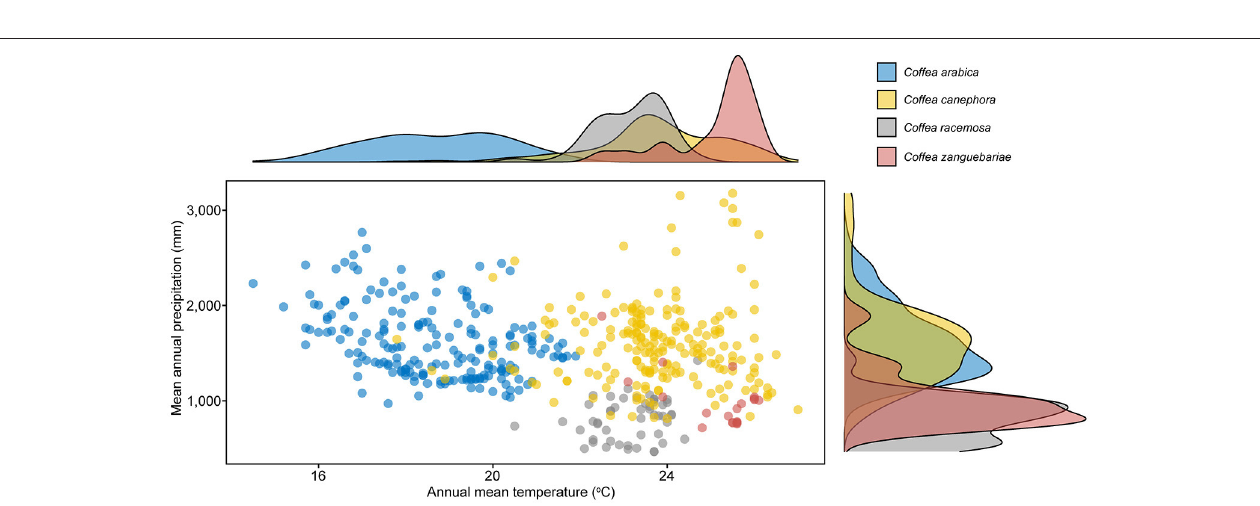
FIGURE 8 | Scatter and density plots of modelled mean annual temperature (CHELSA bio10_01) vs. total mean annual precipitation (CHELSA bio10_012). Mean values in parentheses: Arabica ( C. arabica ; 18.7 ◦ C/1,614mm); robusta ( C. canephora ; 23.7 ◦ C/1,596mm); wild and cultivated C. racemosa (22.9 ◦ C/807mm) and wild and cultivated C. zanguebariae (24.8 ◦ C/998mm). Disaggregated values for wild and cultivated ( C. racemosa and C. zanguebariae ), and coastal (low elevation) and inland (higher elevation) for C. racemosa are given in Table 3 . See Methods for further details.